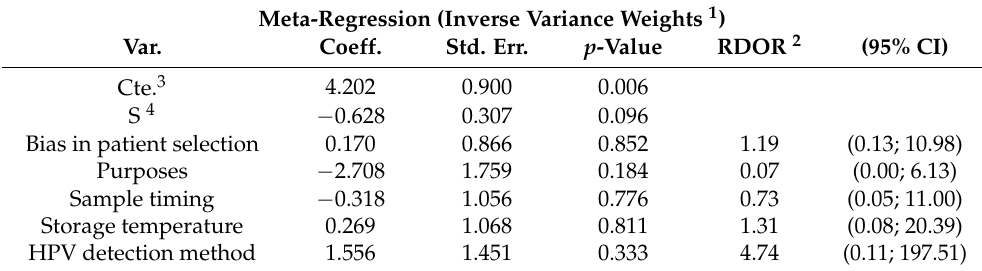
Table 3. Multivariate meta-regression results for characteristics with backward regression